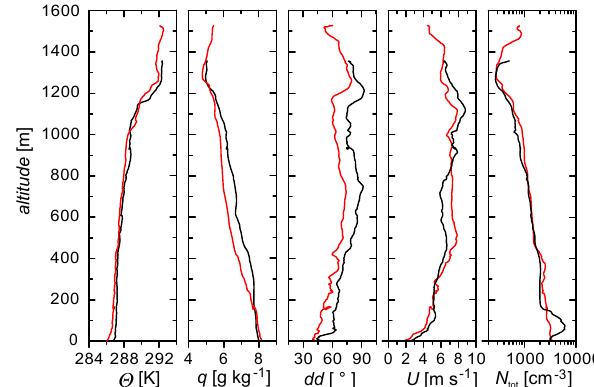
Fig. 2. Scheme of the flight pattern of ACTOS on 5 October 2007. Subfigures show pictures of the observed stratocumulus taken by the on-board camera. Fig. 3. Vertical profiles of potential temperature ( 2 ), absolute hu- midity ( q ), wind direction ( dd ), wind velocity ( U ) and total particle number concentration ( N tot ) recorded during ascent (black lines) and descent (red lines). Note that vertical profiles were performed in cloud free area.